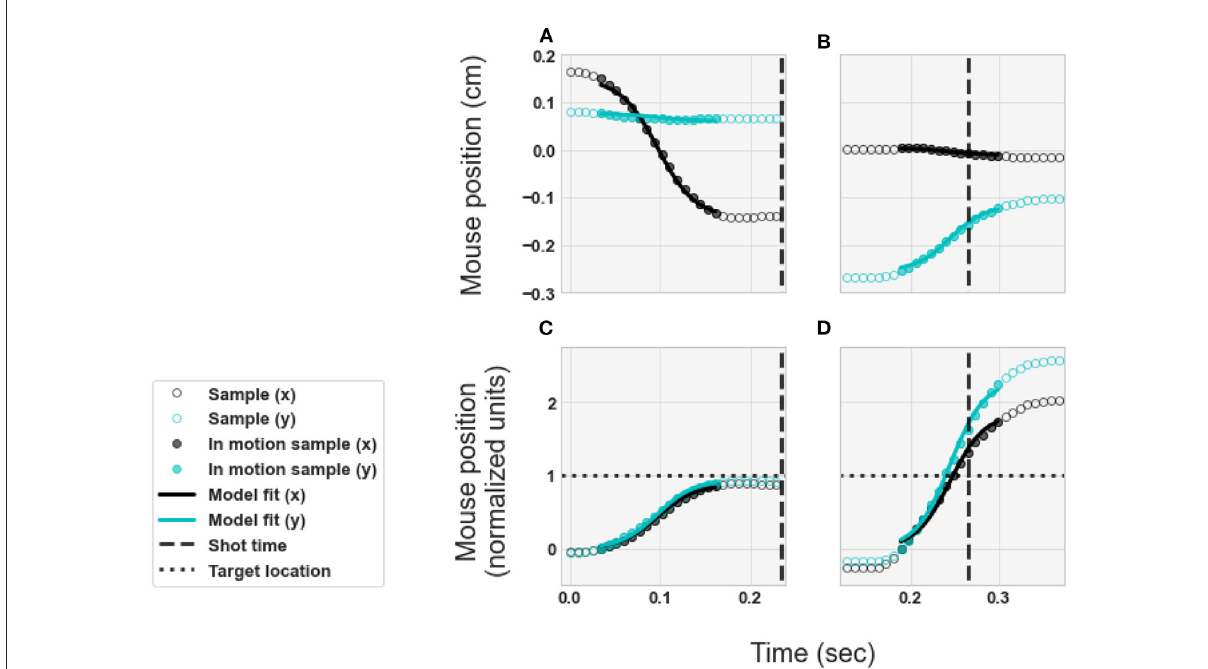
FIGURE2 Examples of the movement trajectories and model fits. (A,C) Example flick-and-land. (B,D) Example swipe. (A,B) Physical movements in units of centimeters. (C,D) Normalized units - so that 1 corresponds to target location. Circles illustrate the samples of the player’s movement trajectory. Curves illustrate the models of the movement trajectories, as expressed by Equations (1–3), with best-fit values for the